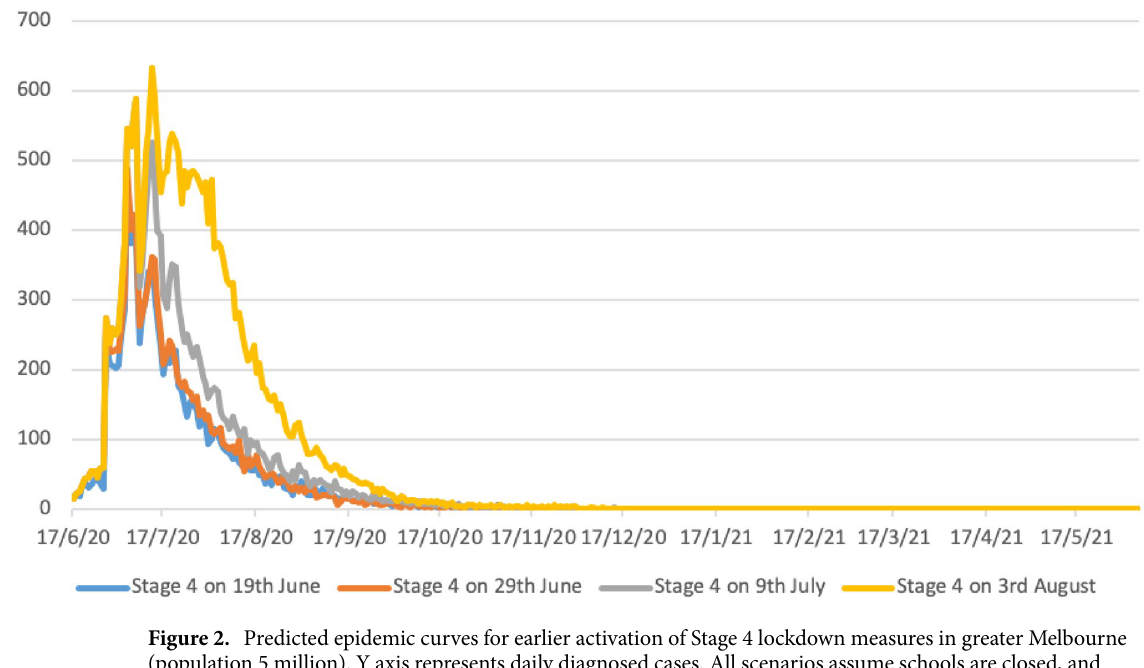
Figure 2. Predicted epidemic curves for earlier activation of Stage 4 lockdown measures in greater Melbourne (population 5 million). Y axis represents daily diagnosed cases. All scenarios assume schools are closed, and there is 90% case isolation for adults and 100% for children. X axis gives calendar dates; Y axis predicted case numbers.